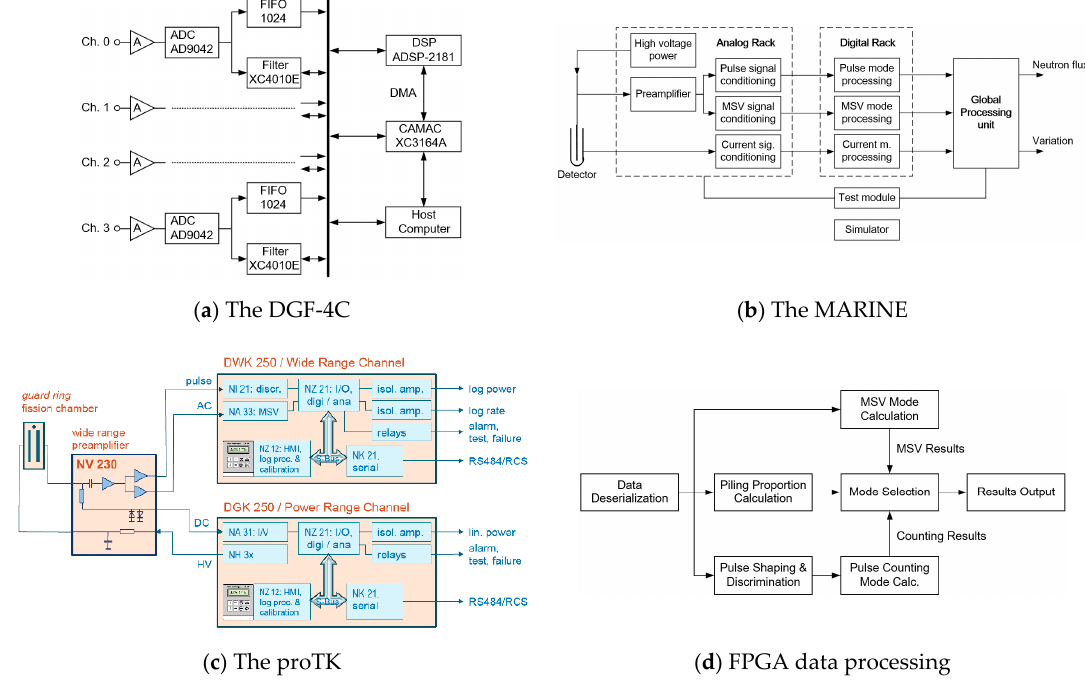
Figure 1. Simplified block diagrams.